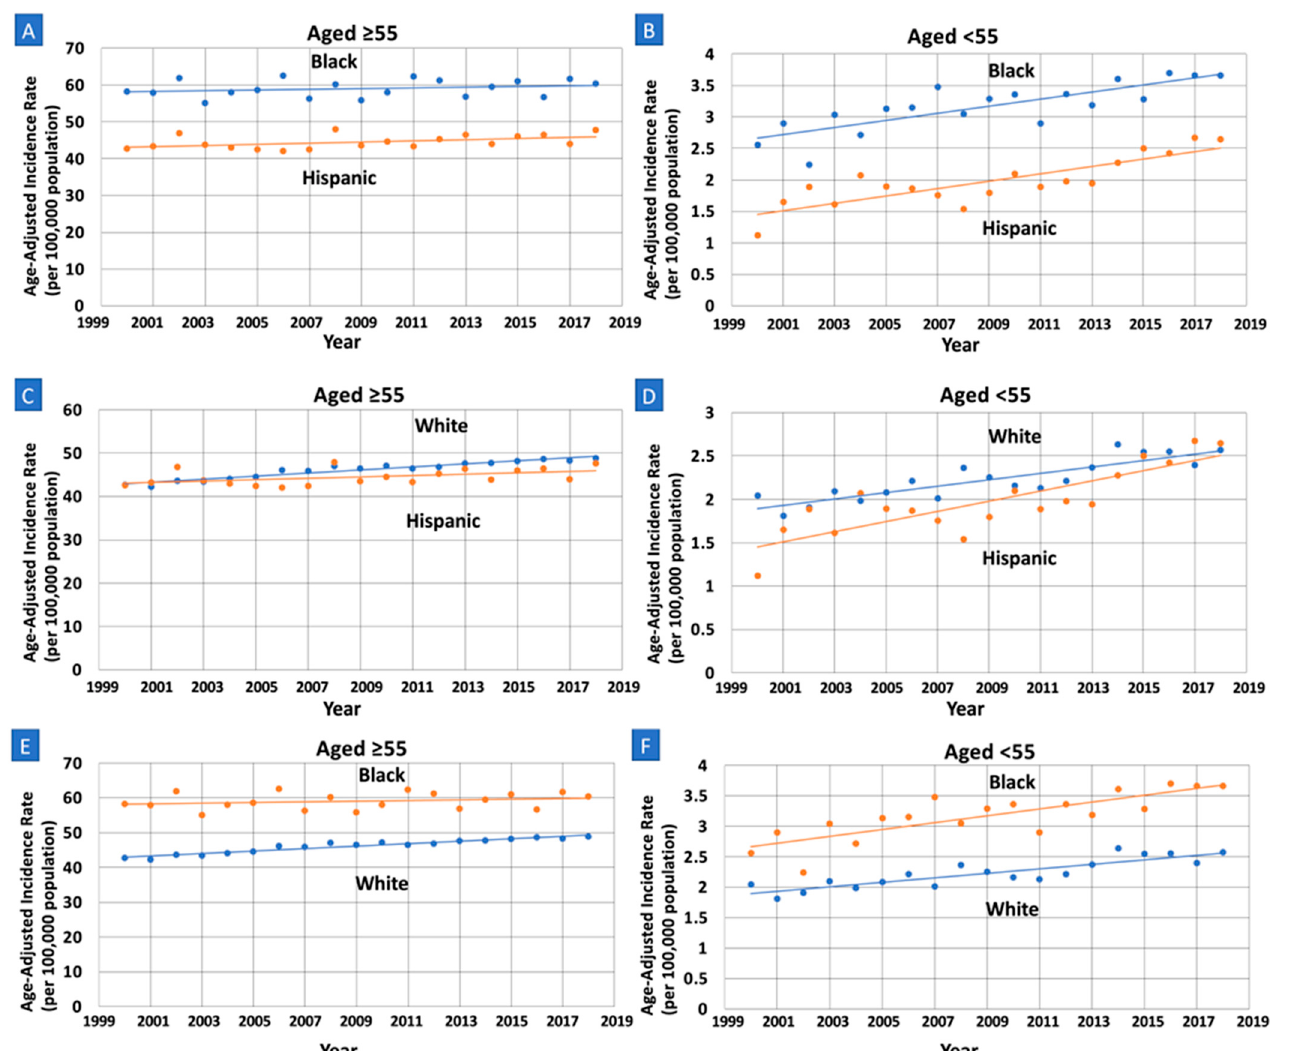
Figure 2. Race and ethnicity specific trends and age-adjusted pancreatic cancer incidence rates per 100,000 people among older (Age ≥ 55) and younger women (Age < 55). APC: annual percent change. ( A ): APC increasing in Hispanics and unchanged in Black older women; there is no significant difference (0.38 vs. 0.17, p = 0.34). ( B ): APC increasing at a greater rate in Hispanic compared to Black younger women (3.03 vs. 1.74, p = 0.028), with trends that are parallel ( p = 0.074) and non-identical ( p < 0.01). ( C ): APC increasing at a greater rate in White compared to Hispanic older women (0.80 vs. 0.38, p = 0.021), with trends that are non-parallel ( p = 0.016) and non-identical ( p < 0.01). ( D ): APC increasing at a greater rate in Hispanic compared to White younger women (3.03 vs. 1.68, p < 0.001), with trends that are parallel ( p = 0.070) and non-identical ( p < 0.01). ( E ): APC increasing at a greater rate in White compared to Black older women (0.80 vs. 0.17, p = 0.001), with trends that are non-parallel ( p < 0.01) and non-identical ( p < 0.01). ( F ): APC increasing in Black and White younger women, with no significant difference (1.74 vs. 1.68, p =